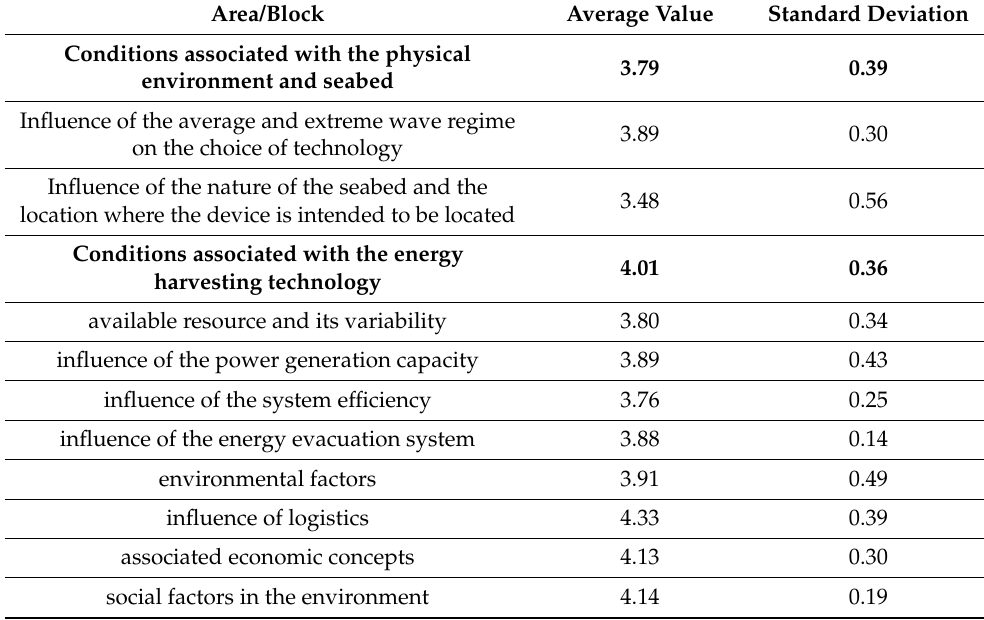
that comprise them after round